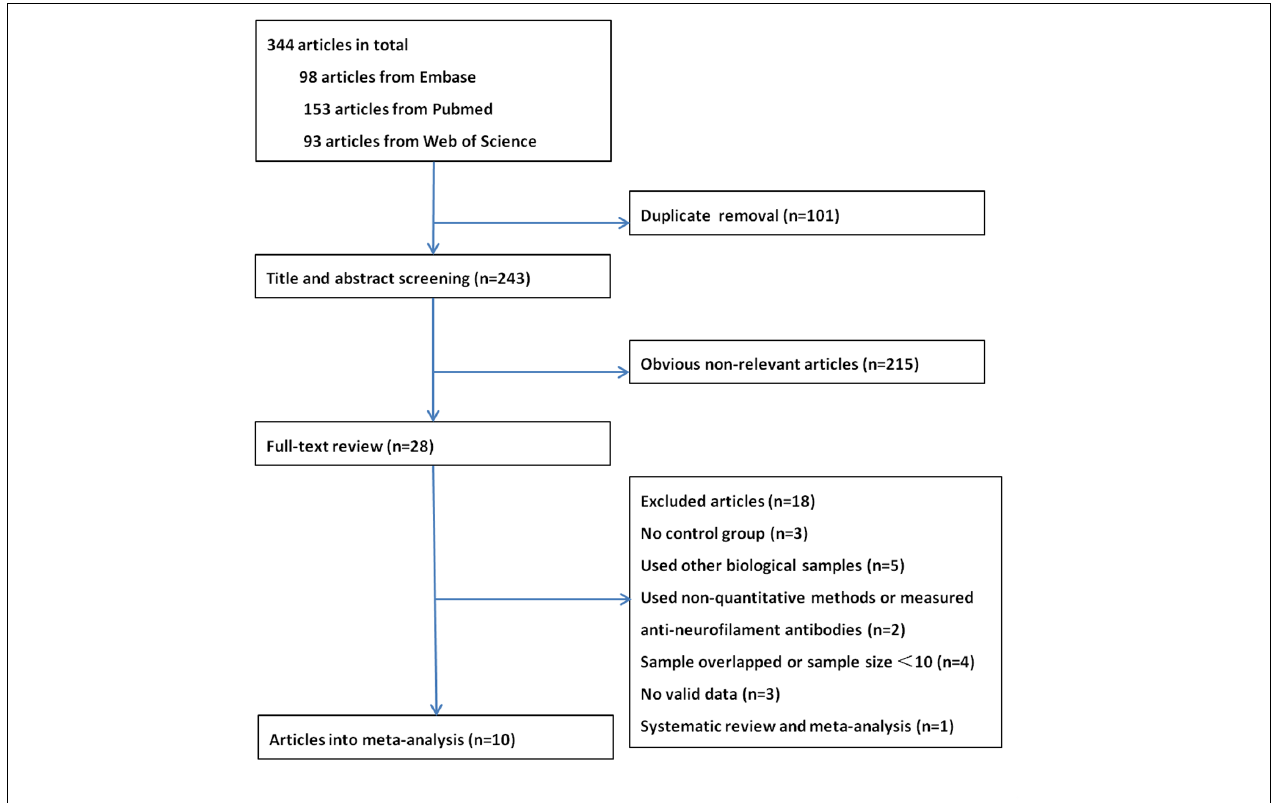
FIGURE 1 | The flow chart of the literature search in the